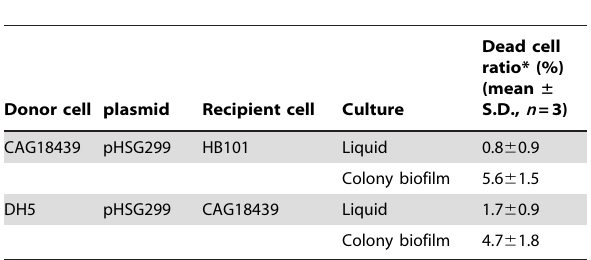
Table 5. Measurement of the dead cell ratio in liquid and colony biofilm